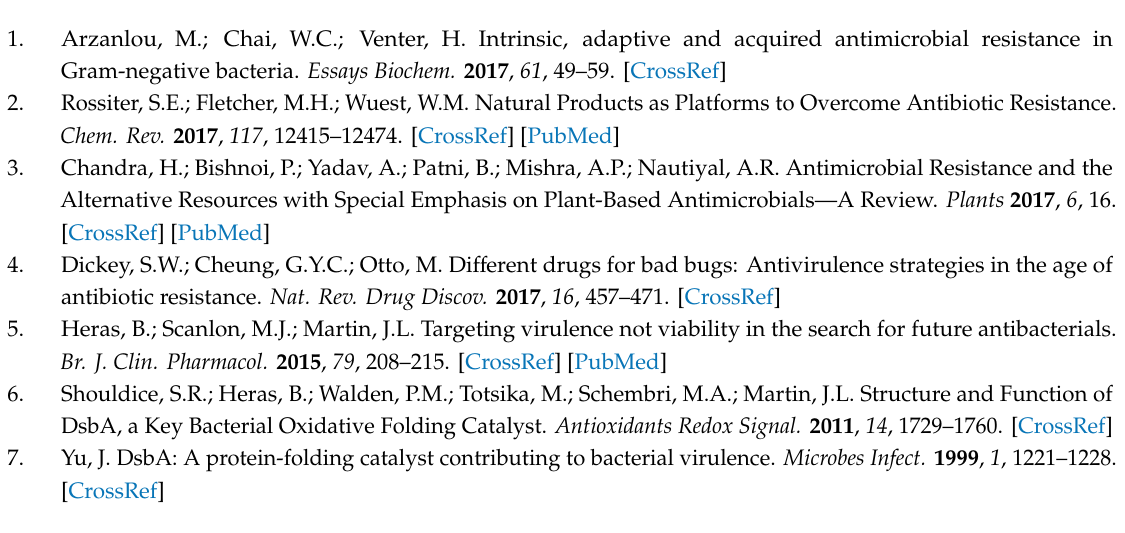
Figure S1: Time course assay for the determination of the optimal bacterial biofilm formation time, Table S1: Docking scores and ligand e ffi ciencies of Manuka and / or Heather honey constituents towards Pa